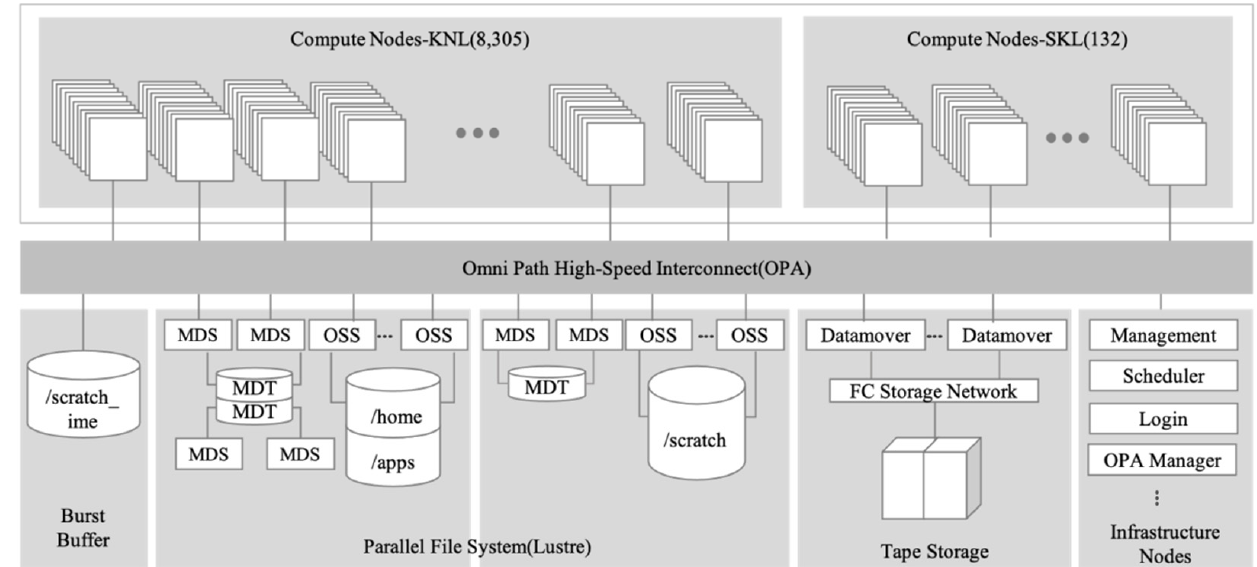
Figure 1. Hardware architecture of the Nurion supercomputer.